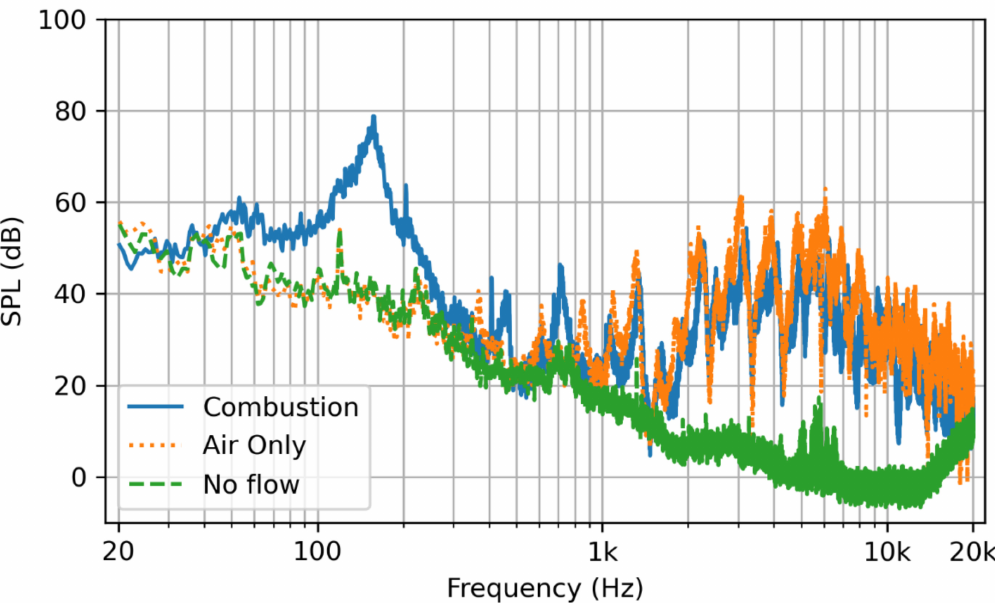
Figure 9. The SPL spectrum for combustion in a solid blue line, air flow only in a dotted orange line, and no flow conditions in the dashed green